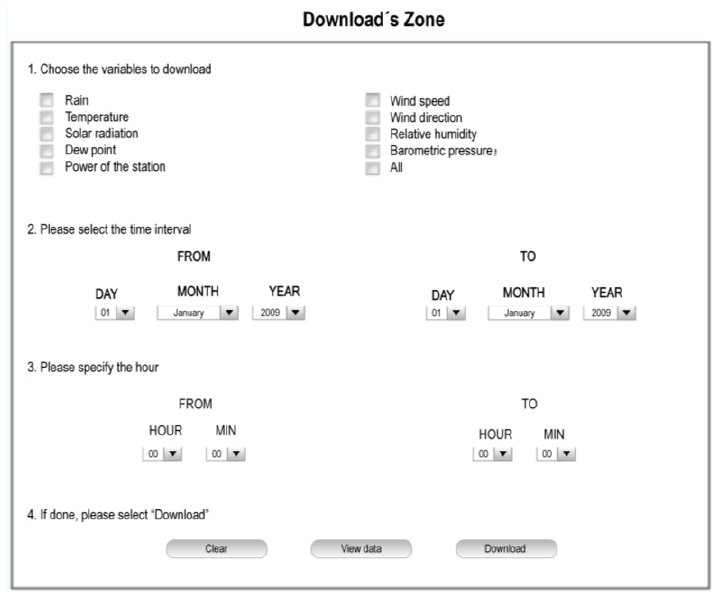
Figure 18 . Downloads zone oriented to the final user.